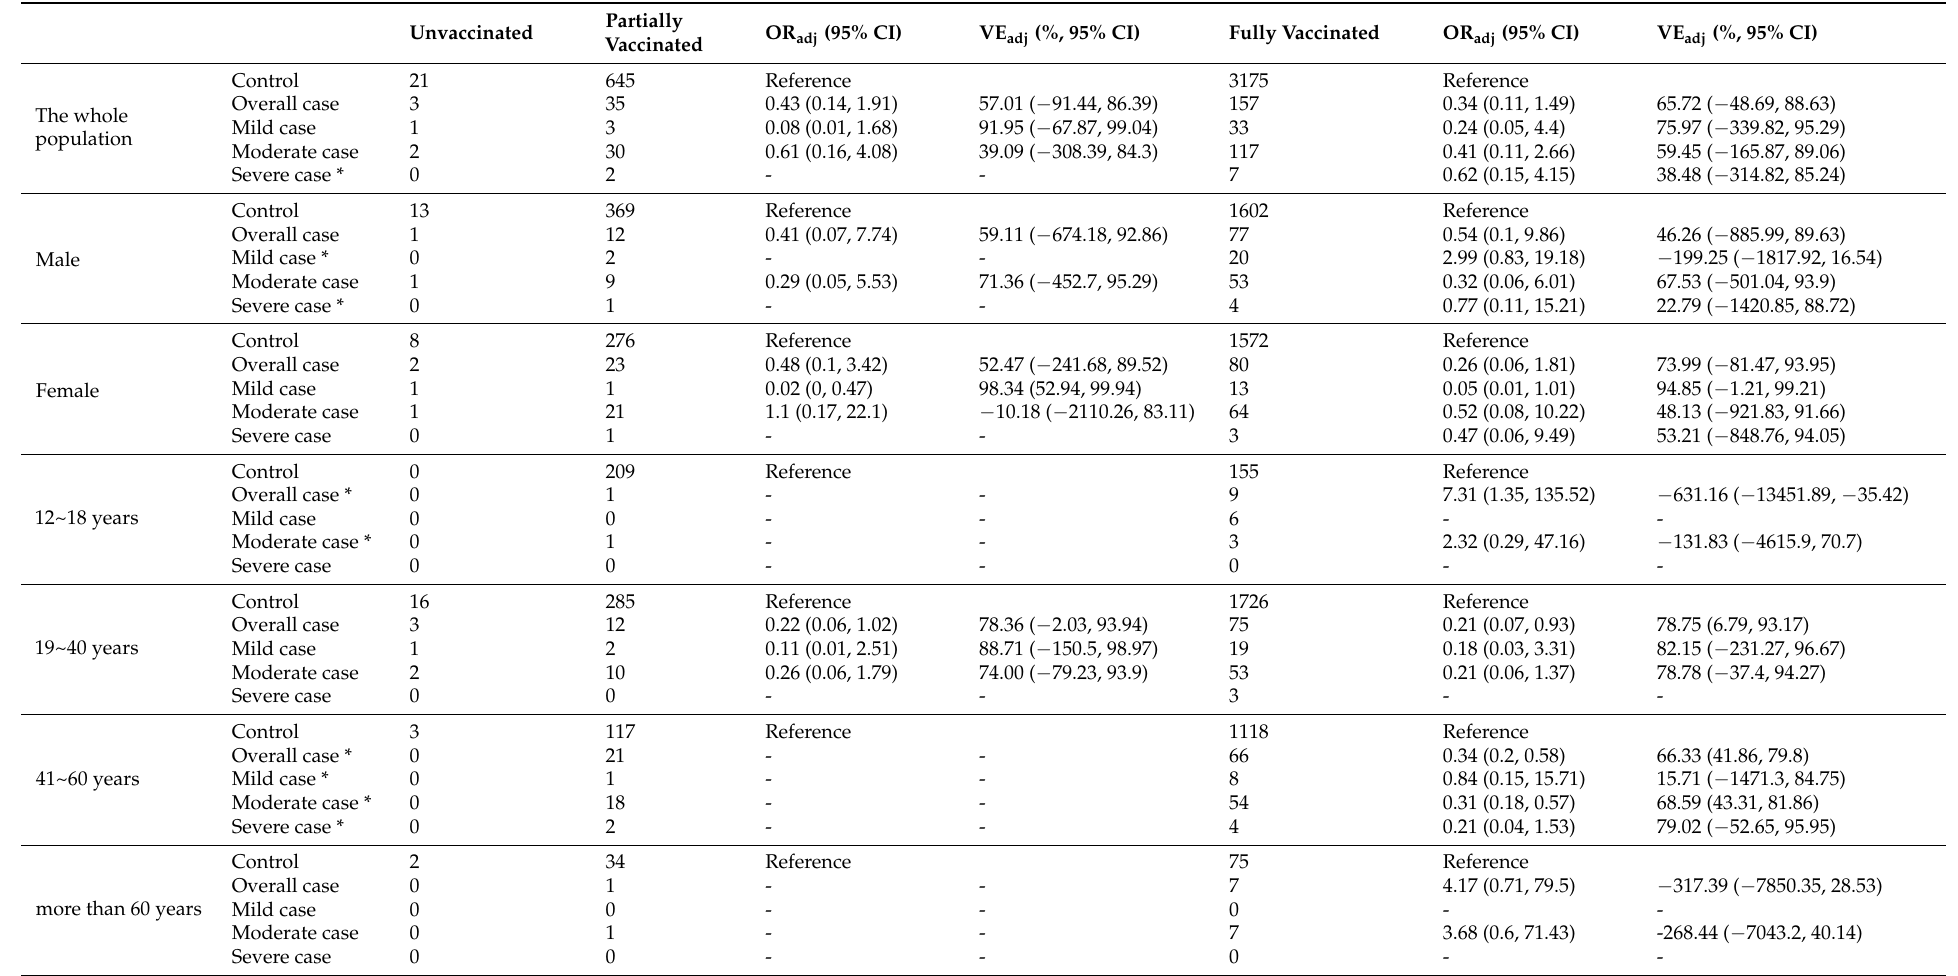
Table 3. Estimates of the association between vaccination and SARS-CoV-2 infection and effectiveness of inactivated SARS-CoV-2 vaccines.